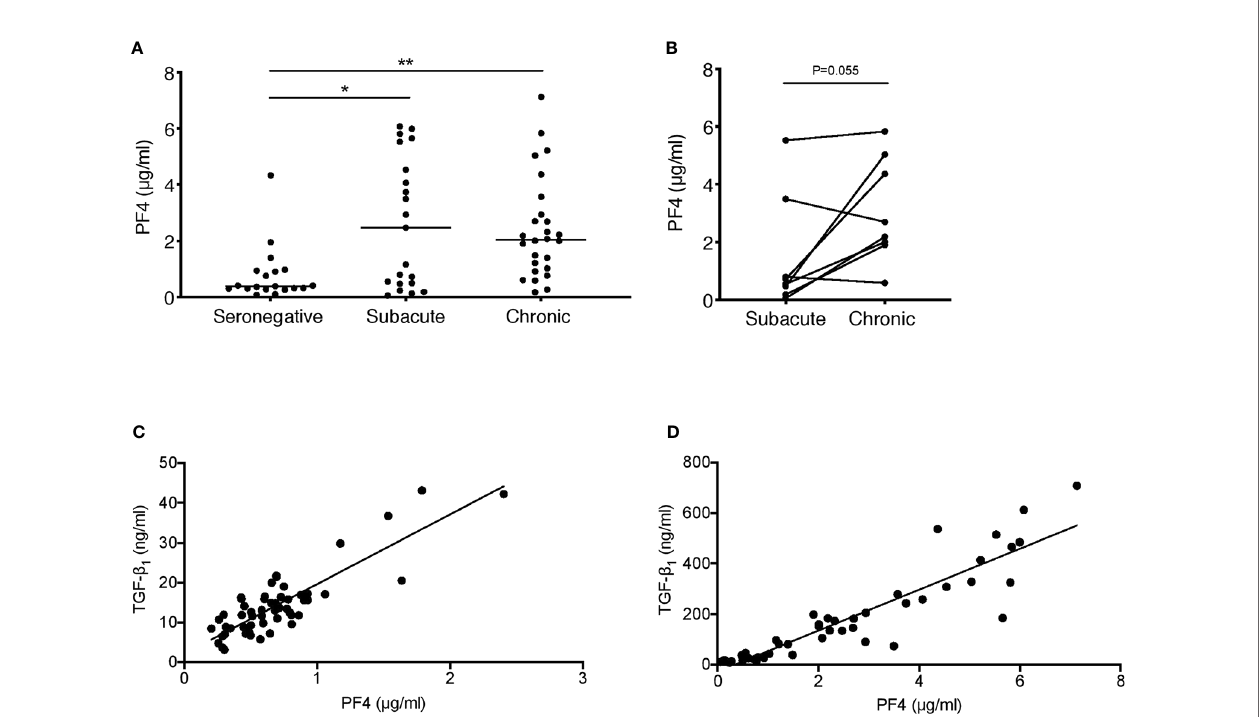
FIGURE 4 | Correlation between plasma concentrations of PF4 and TGF- b 1 in HIV-1 − infected individuals. (A) PF4 levels were measured in plasma samples from the HIV-infected individuals sampled cross-sectionally during subacute (within 30 days FOSx) or chronic (> 2 years FOSx) untreated infection and demographically matched HIV-seronegative control subjects studied in Figure 3 . Symbols represent datapoints from individual subjects (datapoints included: n=19 seronegative, n=21 subacute and n=26 chronic); and horizontal lines denote the group median. The statistical signi fi cance of differences between groups was assessed by Kruskal-Wallis test with Dunn ’ s post-test (*P < 0.05, **P < 0.01). (B) Paired data from n=8 subjects from whom samples were available at time-points in both subacute and chronic infection were analyzed by two-tailed Wilcoxon signed-rank test. (C) Correlation between TGF- b 1 and PF4 concentrations in n=56 samples from n=9 plasma donors acutely infected with HIV-1, analyzed by two-tailed Spearman ’ s rank correlation coef fi cient (r=0.71, P<0.0001). (D) Correlation between TGF- b 1 and PF4 concentrations in n=47 samples from n=39 individuals sampled during subacute and/or chronic HIV-1 infection, analyzed by two-tailed Spearman ’ s rank correlation coef fi cient (r=0.94, P <